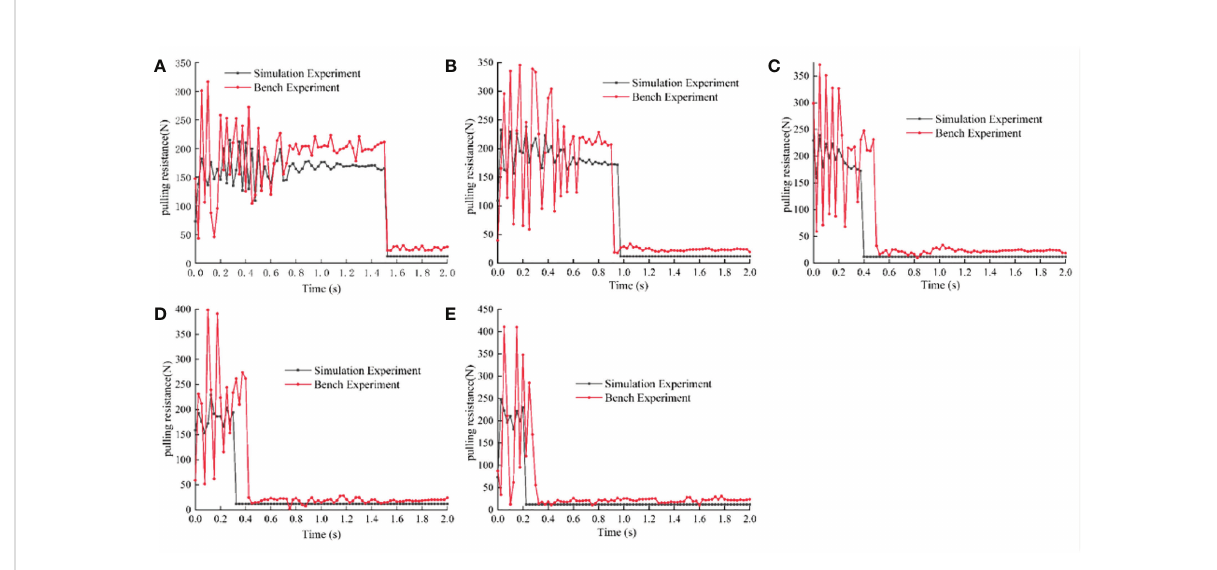
FIGURE 9 Comparison of bench experiment and simulation experiment. (A) Comparison between the bench and simulation when the pulling speed is 0.1m·s-1; (B) Comparison between the bench and simulation when the pulling speed is 0.2m·s-1; (C) Comparison between the bench and simulation when the pulling speed is 0.3m·s-1; (D) Comparison between the bench and simulation when the pulling speed is 0.4m·s-1; (E) Comparison between the bench and simulation when the pulling speed is